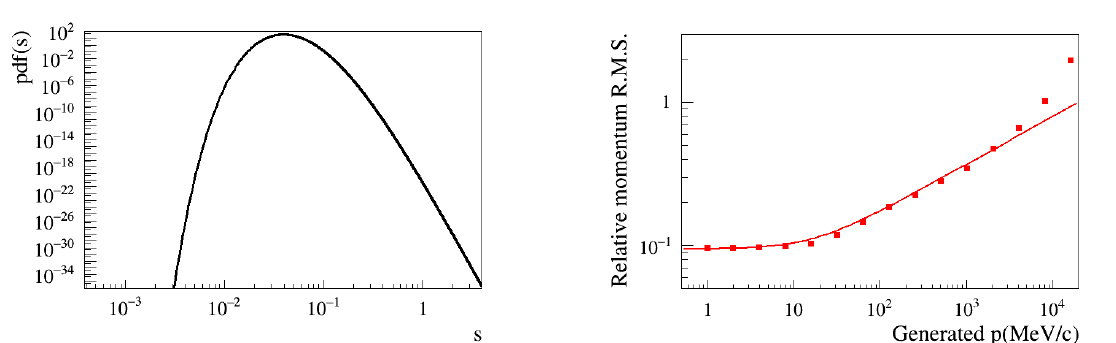
Figure 3. ( Left ) Bayesian probability density function as a function of s , the average multiple-scattering angle variance per unit track length, for a 50MeV/ c track in a silicon detector [30]. On that track, the momentum is measured to be equal to 49.9MeV/ c . ( Right ) The relative R.M.S of the measured momentum, as a function of the true track momentum, for a silicon detector (the curve is the parametrization of Equation (58) of